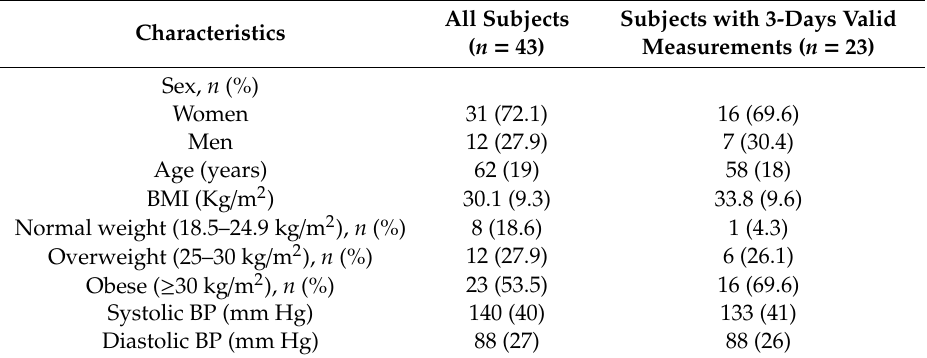
Table 1. Sample demographic and clinical characteristics.